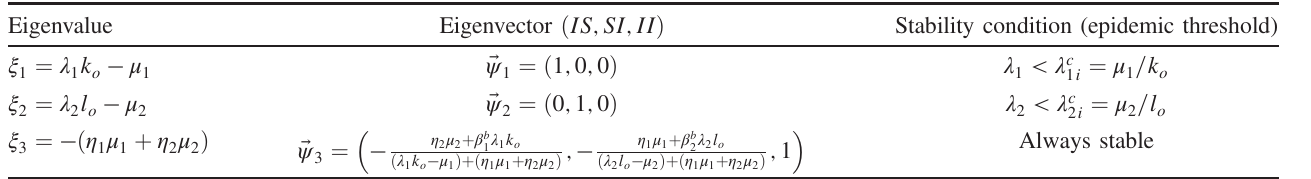
TABLE IV. Linear stability analysis of the fixed point ð IS; SI; II Þ ¼ ð 0 ; 0 ; 0 Þ . Eigenvalue Eigenvector ð IS; SI; II